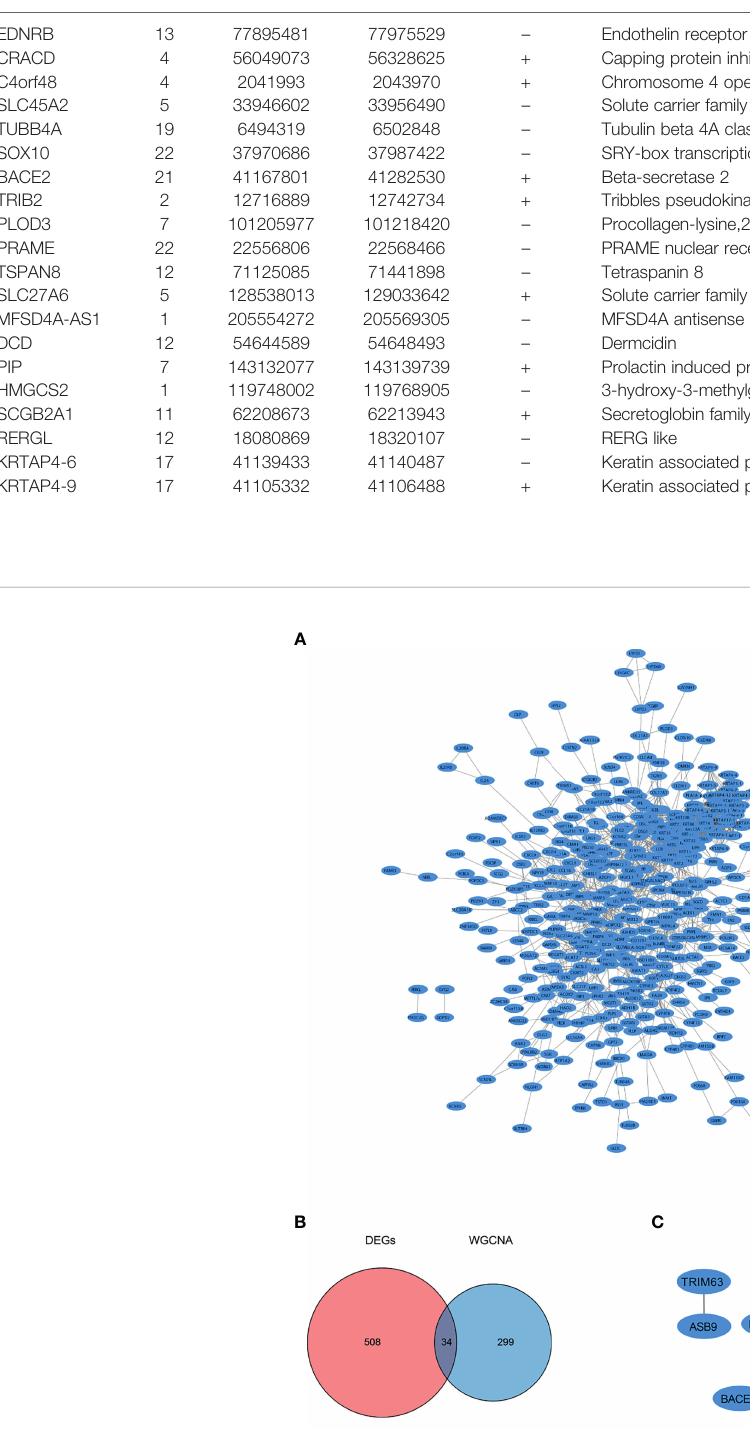
FIGURE 4 | PPI network diagram of the DEGs. (A) PPI network of the genes obtained from DEGs analysis. (B) Intersection of DEGs identi fi ed by the DEGs analysis and SKCM-related genes identi fi ed by WGCNA. (C) PPI network of intersecting DEGs and SKCM-related genes identi fi ed by